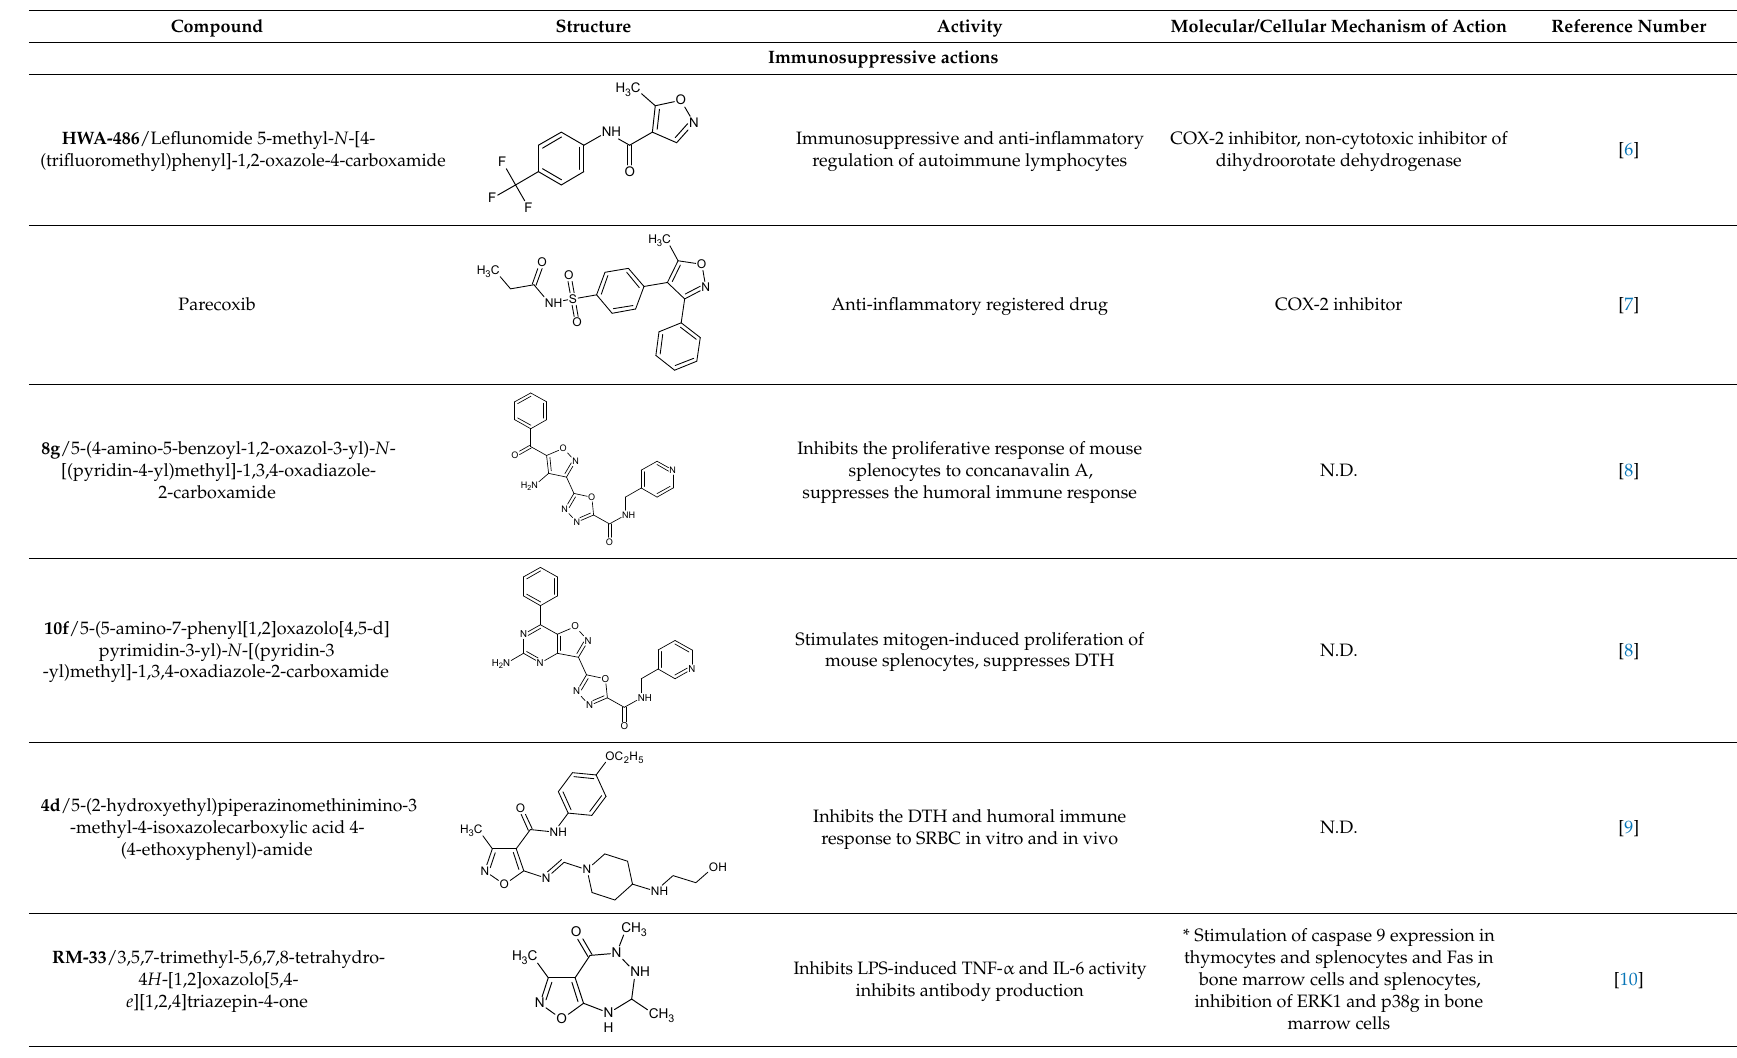
Table 1. Isoxazole derivatives with potential application in therapy.